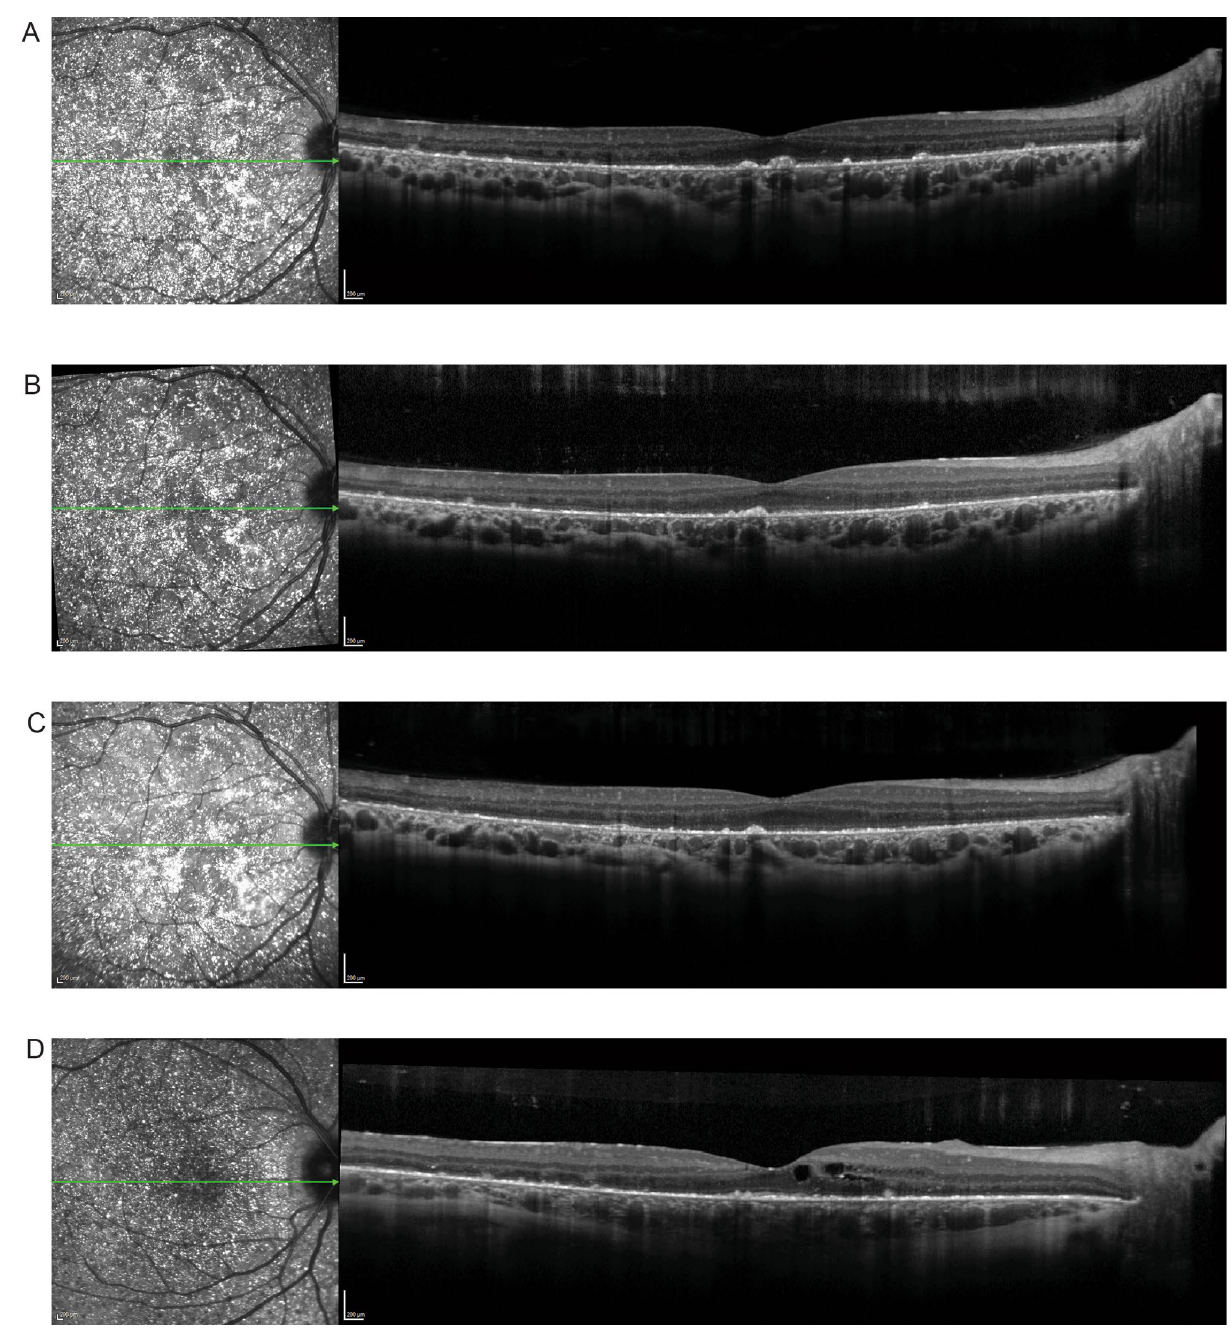
Figure 5. Spectral domain-optical coherence tomography (SD-OCT) for P4 and P6. (A) The horizontal scan through the fovea of the right eye for P4 at initial presentation in our clinic, (B) at a 2-month follow up visit and (C) at a 4-month follow up visit showed maintenance of the retinal layer structure and minor changes in the ONL + area, choroidal thickness, and foveolar thickness. (D) The horizontal scan through the fovea of the right eye of P6 shows an intact EZ band and the beginning of parafoveal cystoid macular edema. The green line in each IR-R image indicates the position of the SD-OCT